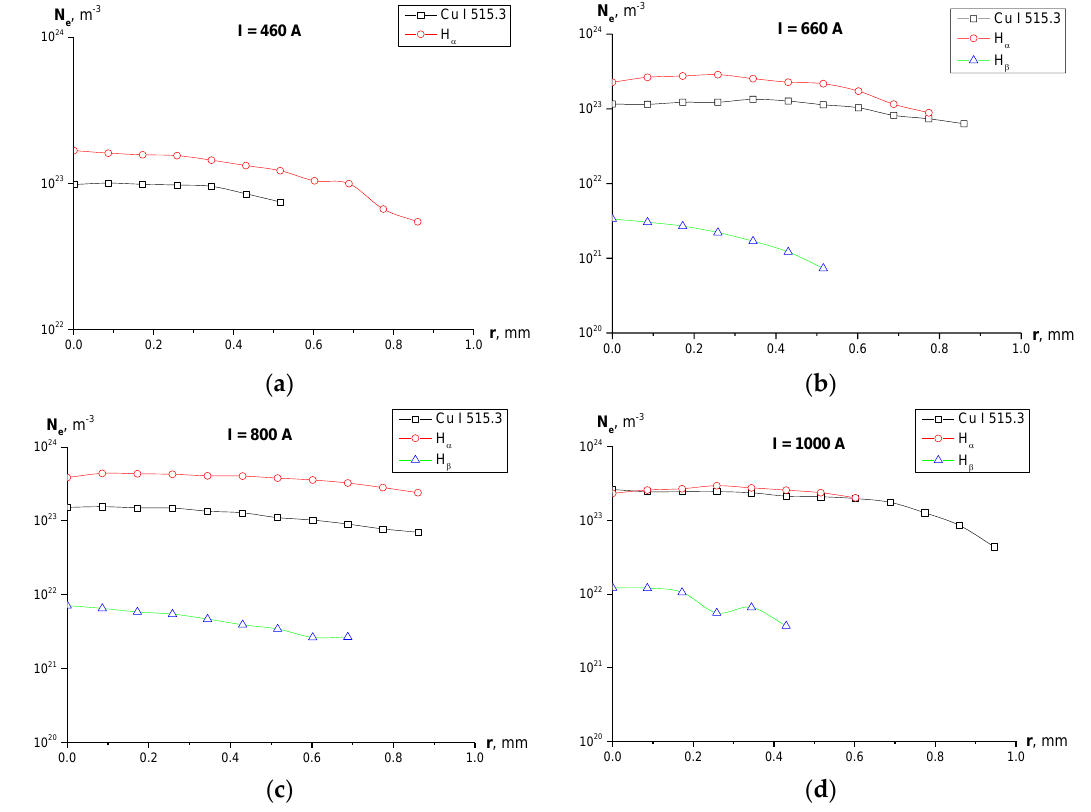
Figure 5. Radial profiles of the electron density calculated using broadening of the selected registered lines for different experimental current regimes: ( a ) I = 450 A, Ne calculated using Cu I 515.3 nm line and H α line; (H β line was not registered for this regime); ( b ) I = 660 A, Ne calculated using Cu I 515.3 nm, H α and H β lines; ( c ) I = 800 A, Ne calculated using Cu I 515.3 nm, H α and H β lines; ( d ) I = 1000 A, Ne calculated using Cu I 515.3 nm, H α and H β lines.